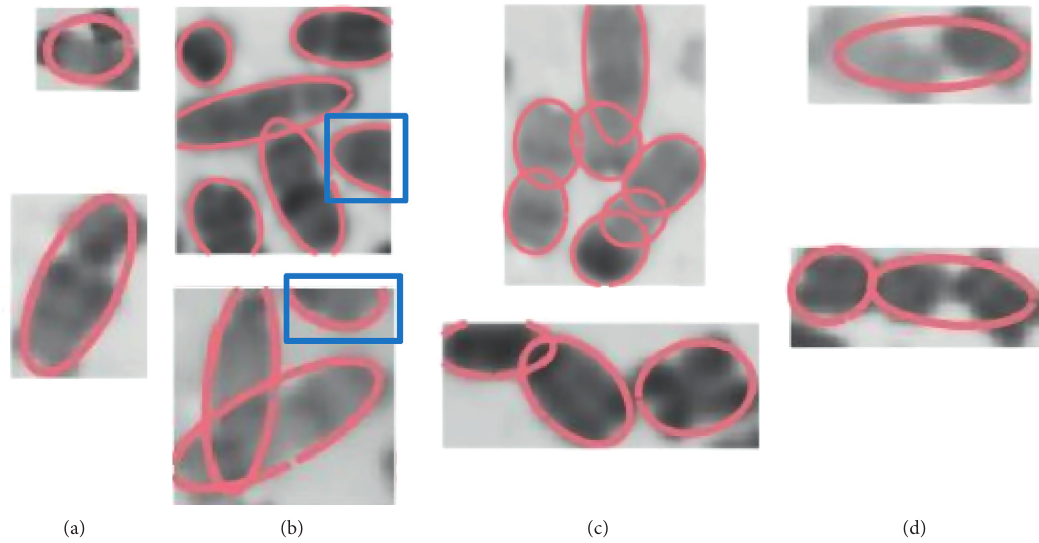
Figure 6: Results for chromosome overlapping segmentation: individual chromosome (a), successful segmentation of chromosome clusters (b), and failure cases requiring manual modification (c) and